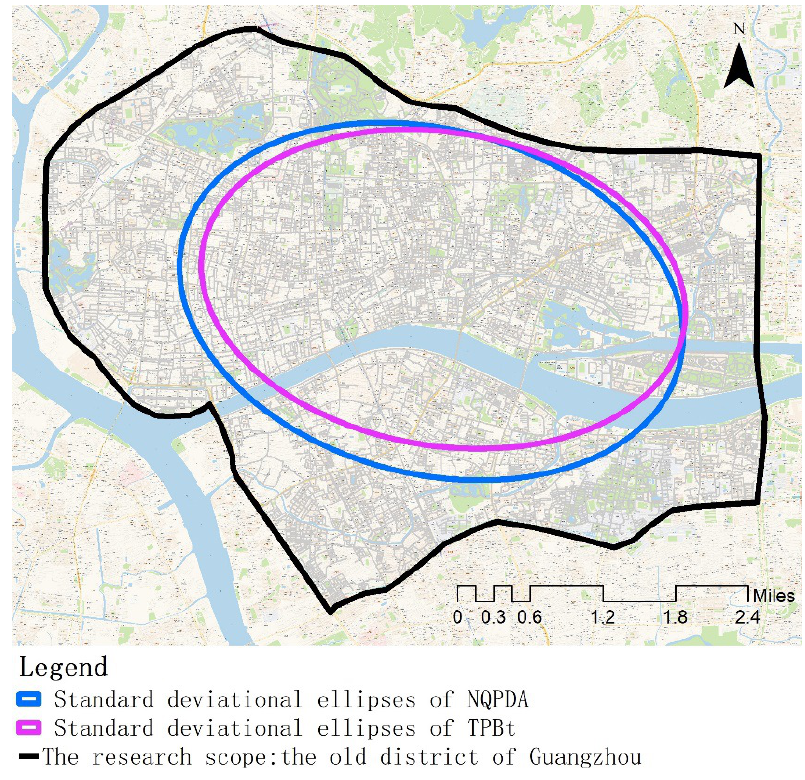
Fig. 26 Standard Deviational